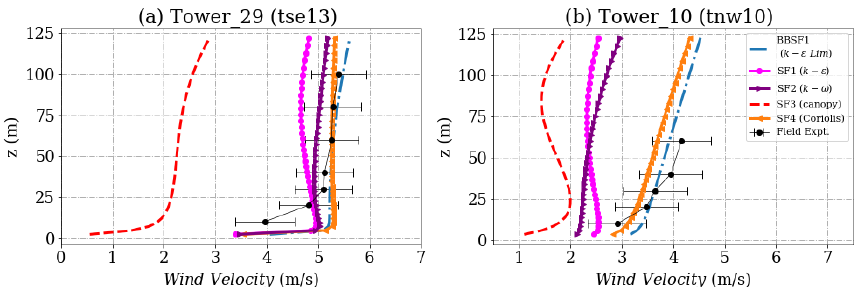
Figure 16. Simulation results and experimental data for wind velocity on the northeast ridge for (a) Tower 29 (tse13) and (b) Tower 10 (tnw10). The locations of the masts are given in Fig.